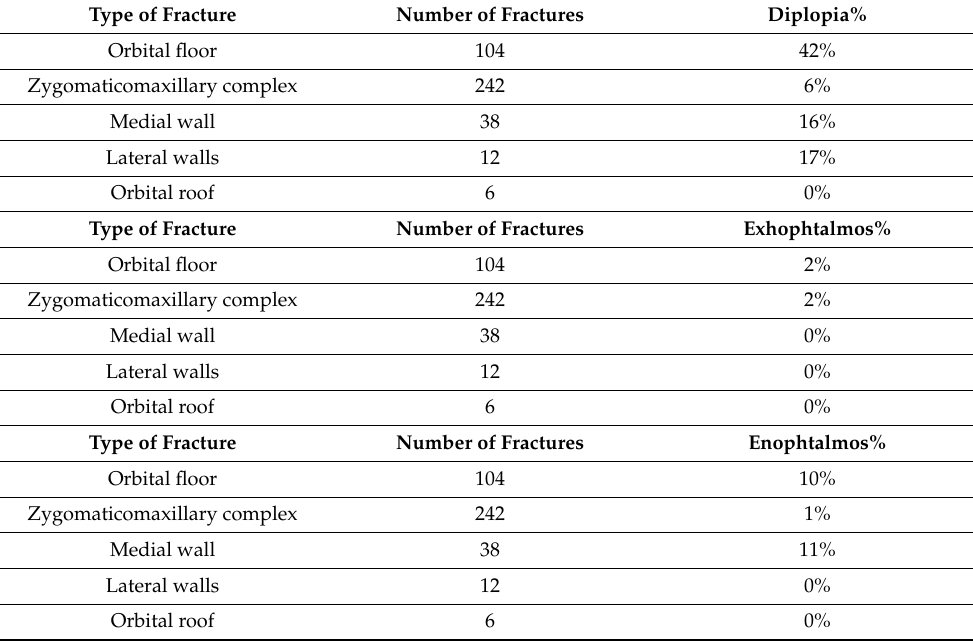
Table 1. Correlation between fractures and orbital side